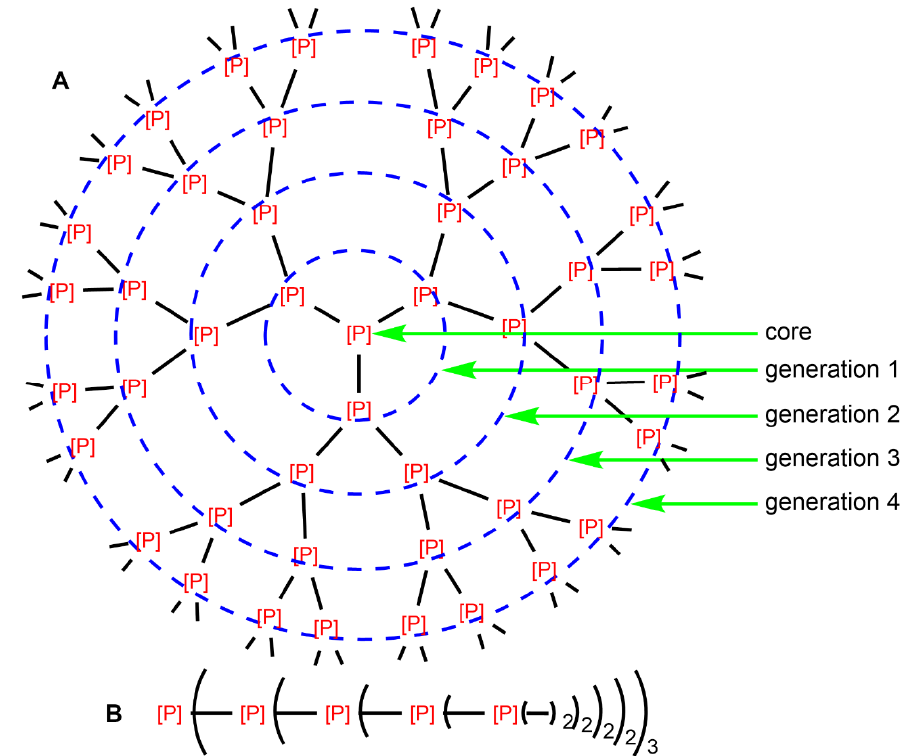
Figure 1. Two types of schematized structure of dendrimers (generation 4) having phosphorus atoms at each branching point, either of type phosphine, or issued from the reaction of phosphines. ( A ): Full structure; ( B ): Linear representation of the same dendrimer.